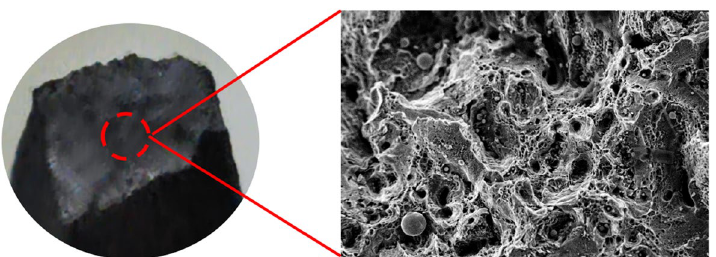
Fig. 9 Fractography of Fe‑SMA monotonic tensile coupon